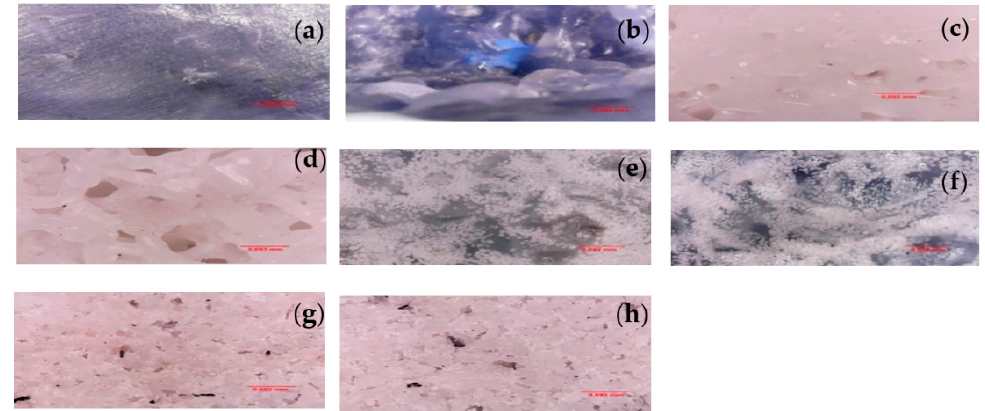
Figure 3. Transmitting light microscopy images of the blocks: ( a , b ) external and internal surface of the PP block, ( c , d ) external and internal surface of the HDPE block, ( e , f ) external and internal sur ‐ face of the PP block with alumina and ( g , h ) external and internal surface of the HDPE block with